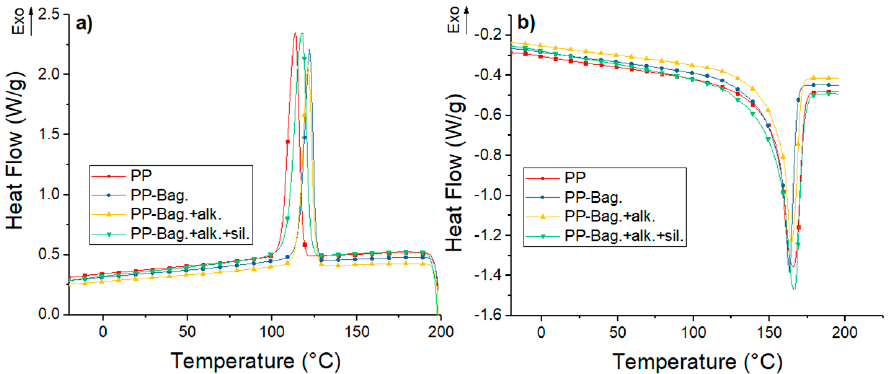
Figure 4. ( a ) Cooling and ( b ) second heating DSC curves for first processing cycle PP and PP-Bagasse biocomposites.